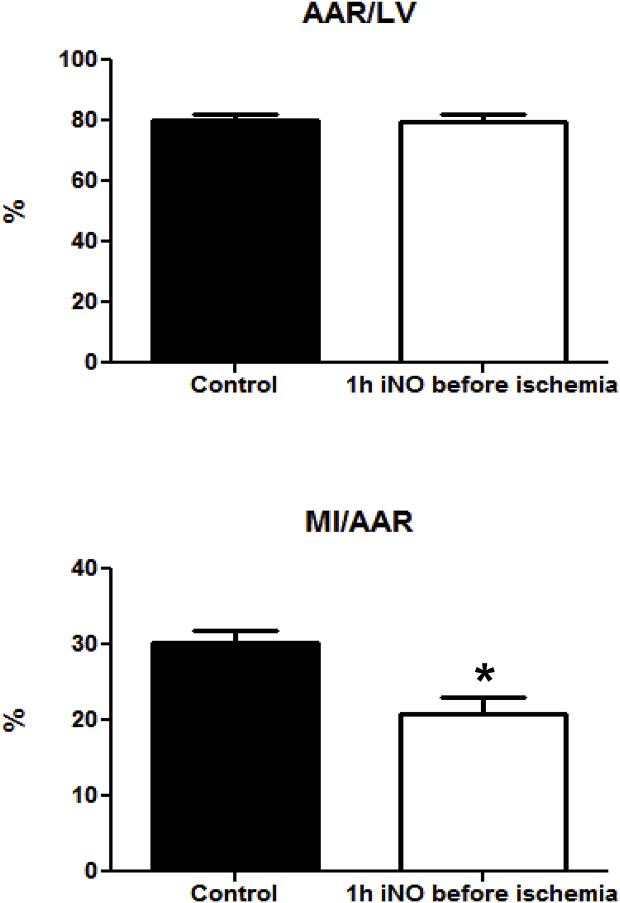
Pretreatment of NO inhalation limits myocardial ischemia–reperfusion injury. All mice underwent left coronary artery occlusion for 60 min followed by 24 h of reperfusion. Mice received 80 ppm NO, prior to coronary artery occlusion for 60 min (n = 10 and 8 for control and inhaled NO, respectively). Control mice did not receive NO. Breathing NO decreased MI/AAR by 30% (*P = 0.002 versus control, lower panel). AAR/LV did not differ between two groups (upper panel). AAR = area at risk; LV = left ventricle; MI = myocardial infarction.